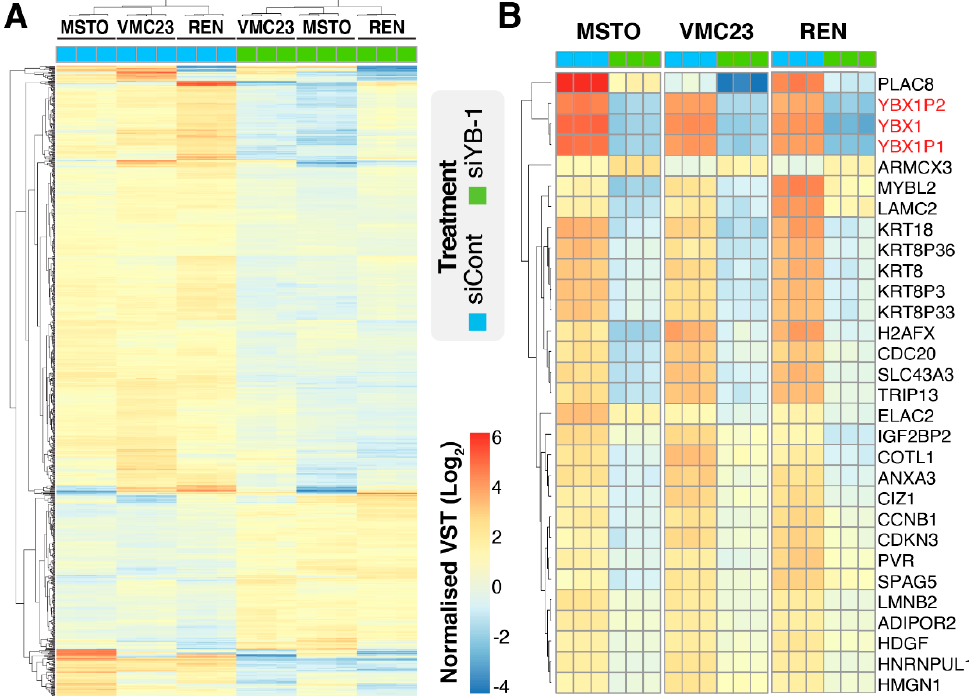
Figure 1. Transfection of YB-1 siRNA downregulates several core cell cycle gene transcripts. ( A ) Heatmap of all altered genes identified by RNA-seq and ( B ) of the top 30 altered genes of RNA-seq data of MSTO-211H, VMC23 or REN cells transfected with siCont or siYB-1 #1, based on significance (FDR). Experiments were repeated three times. Heatmaps with two-way hierarchical clustering were generated using R software. The heatmap colour spectrum depicts variance-stabilising transformation (VST) counts relative to the mean value of all VST counts of all samples. Highlighted in red are YBX1 and the two pseudogenes, YBX1P1 and YBX1P2 .